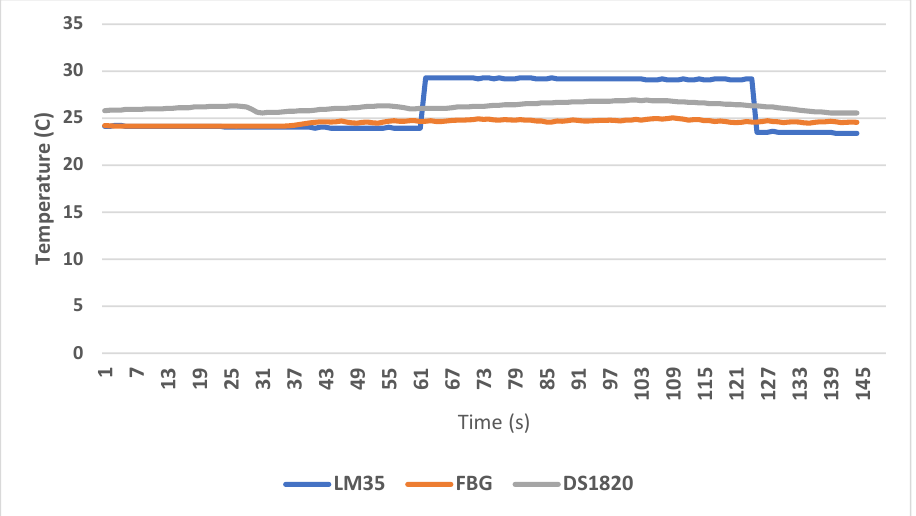
Table 4. Statistics of the measurements of all sensors for discharging the battery.